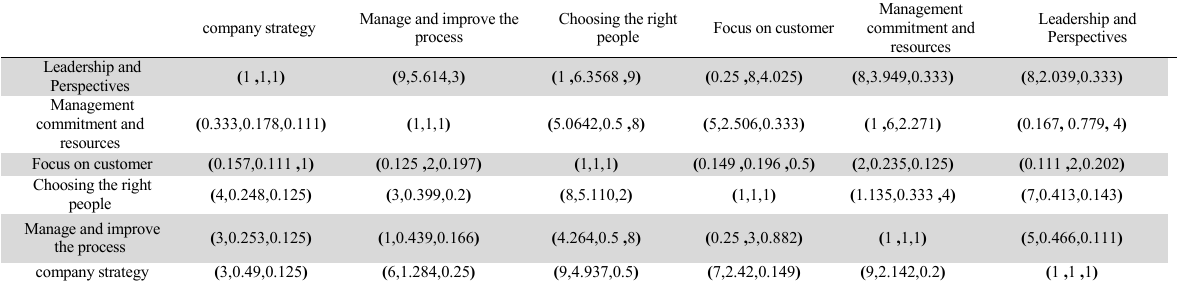
Matrix of Triangular Fuzzy